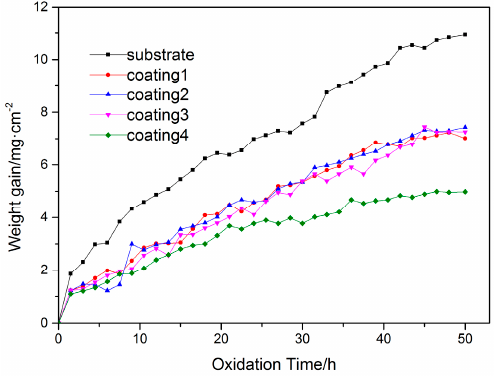
Figure 12. Oxidation weight gain curves of the substrate and cladding coatings at 800 °C.